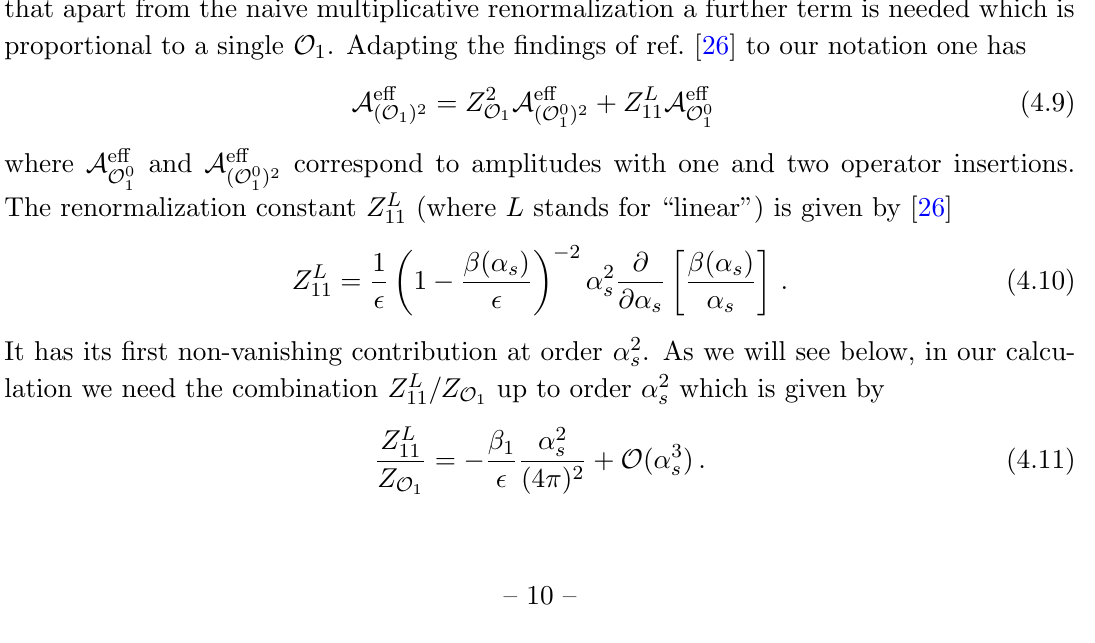
, A e(cid:11) LO ; 1PI LO ; 1PR ;(cid:21) =0